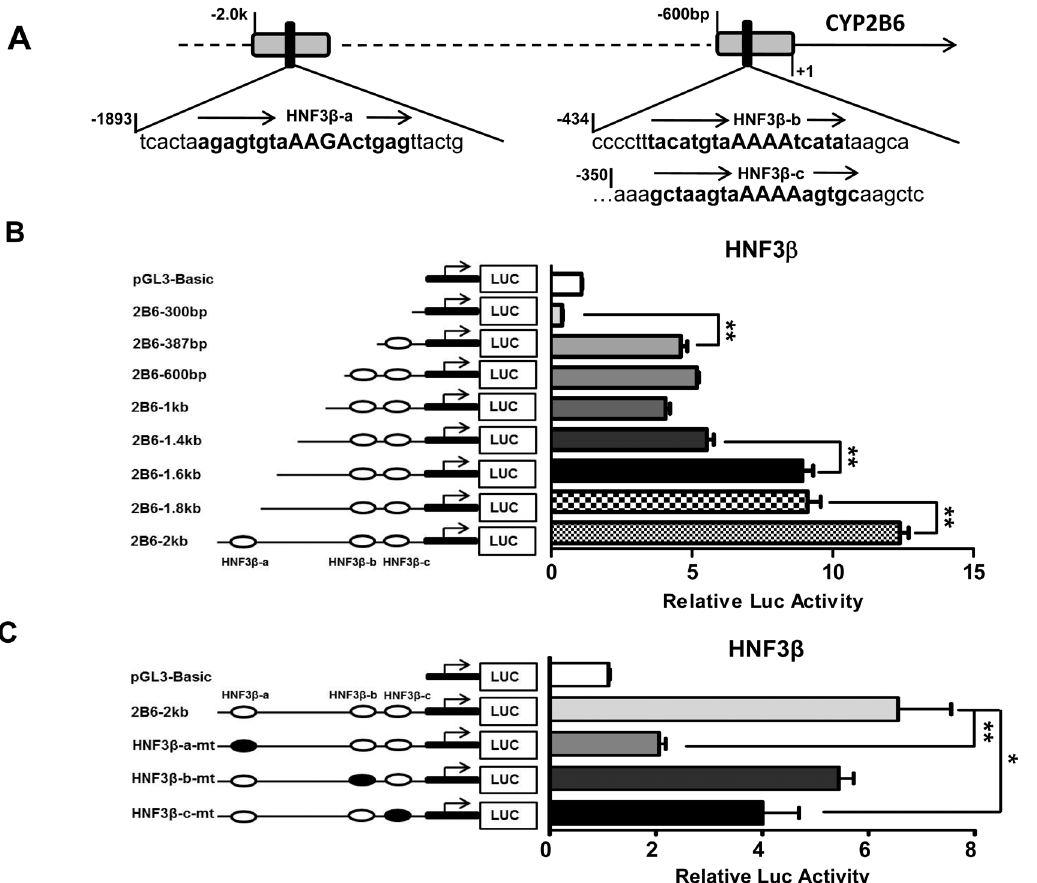
Fig 4. Transactivation of CYP2B6 5 ’ -flanking reporter constructs by HNF3 β . A computer-based search for the first 2 kb of CYP2B6 upstream resulted in the identification of three potential HNF3 β -responsive elements located between -1893bp and -350bp (A). HepG2 cells were transfected with HNF3 β expression vector in the presence of CYP2B6 promoter constructs containing sequential deletion fragments (B) or the CYP2B6-2.0k harboring one of the mutated HNF3 β binding sites (C). Forty eight hours post-transfection, luciferase activities were determined and expressed relative to the control (pGL3-Basic). Data represent the mean ± SD. (n = 3). ( * , p < 0 . 05; ** , p < 0 . 01 ).